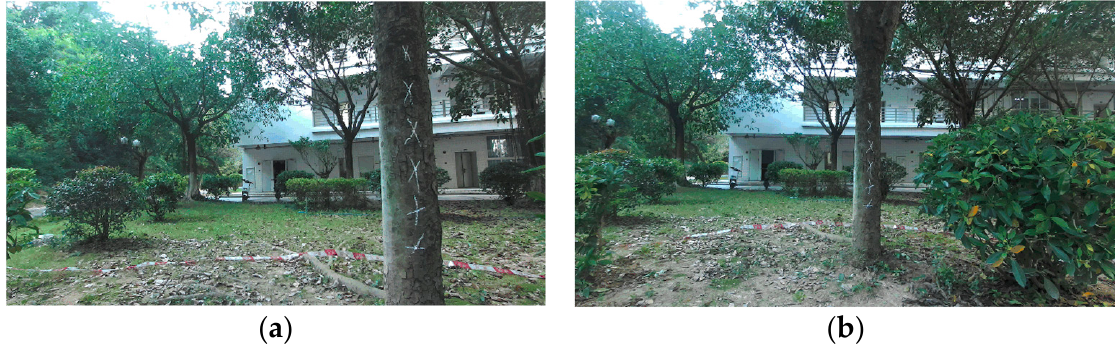
Figure 7. Field test environment: ( a ) 1.5 m; ( b ) 2.8 m.